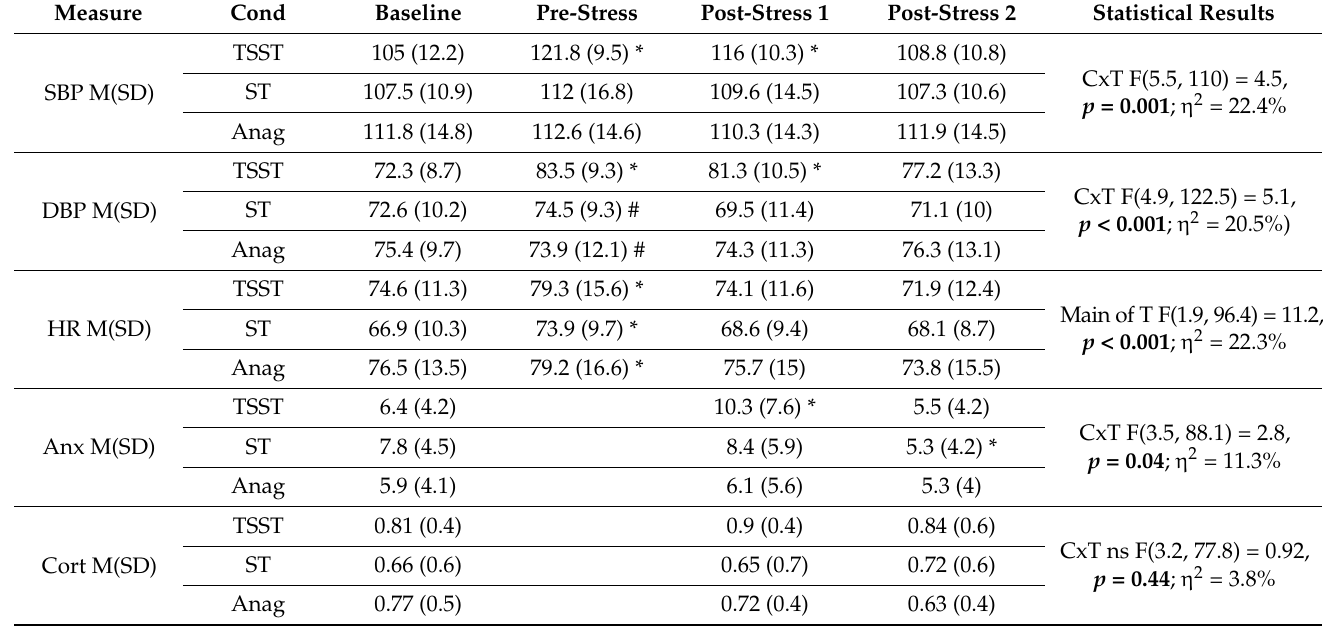
Cond = condition; SBP = systolic blood pressure; DBP = diastolic blood pressure; HR = heart rate; Anx = self-rated anxiety; Cort = salivary cortisol; M = arithmetic mean; SD = standard deviation; TSST = Trier Social Stress Test; ST = singing test; Anag = unsolvable